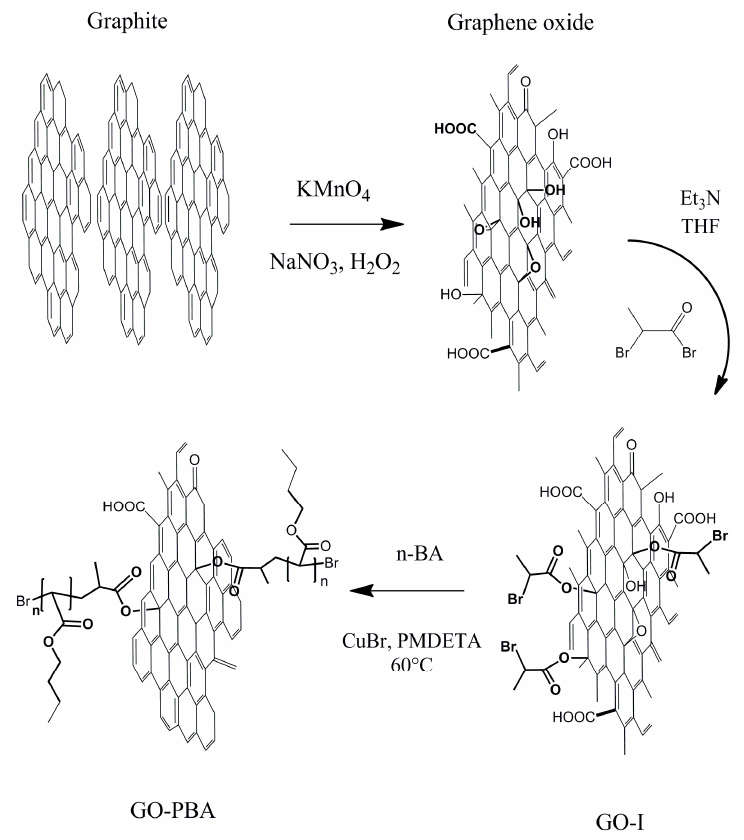
Figure 1. Schematic illustration of the GO modification with PBA polymer brushes.